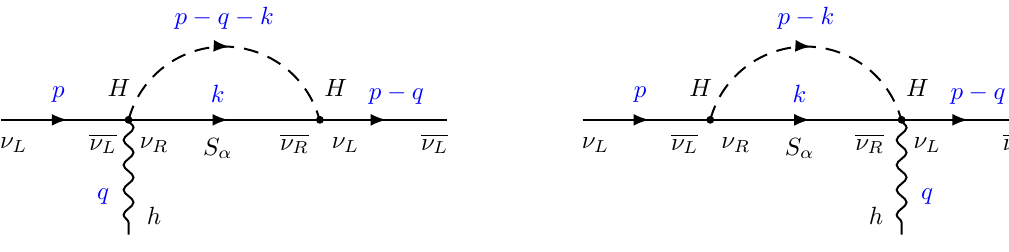
Figure 6 . One-loop self-energy diagrams with h insertions on the Yukawa